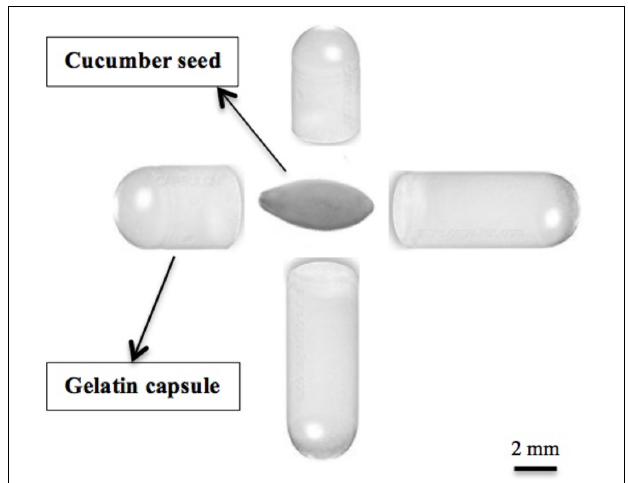
FIGURE 1 | Two gelatin capsules (four halves) placed adjacent to the cucumber